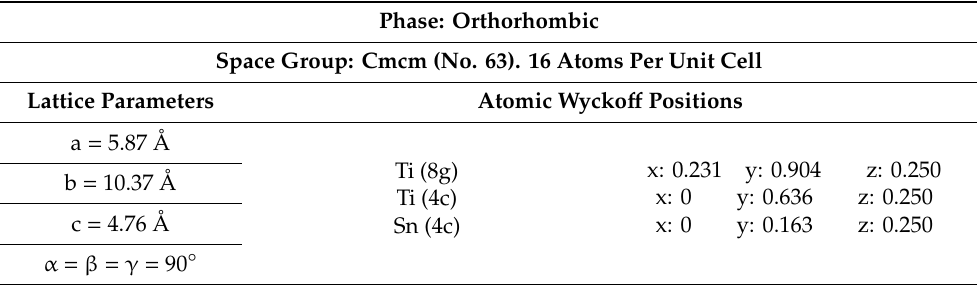
Table 1. Crystallographic details of the new phase of Ti 3